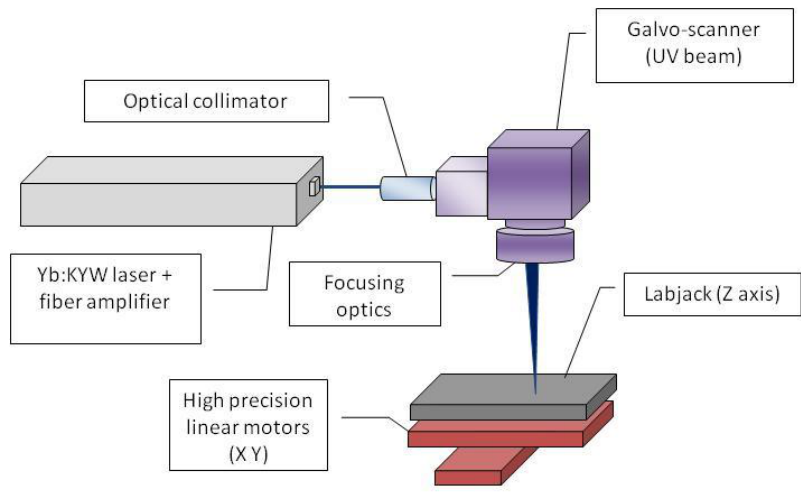
Figure 2. The experimental setup.